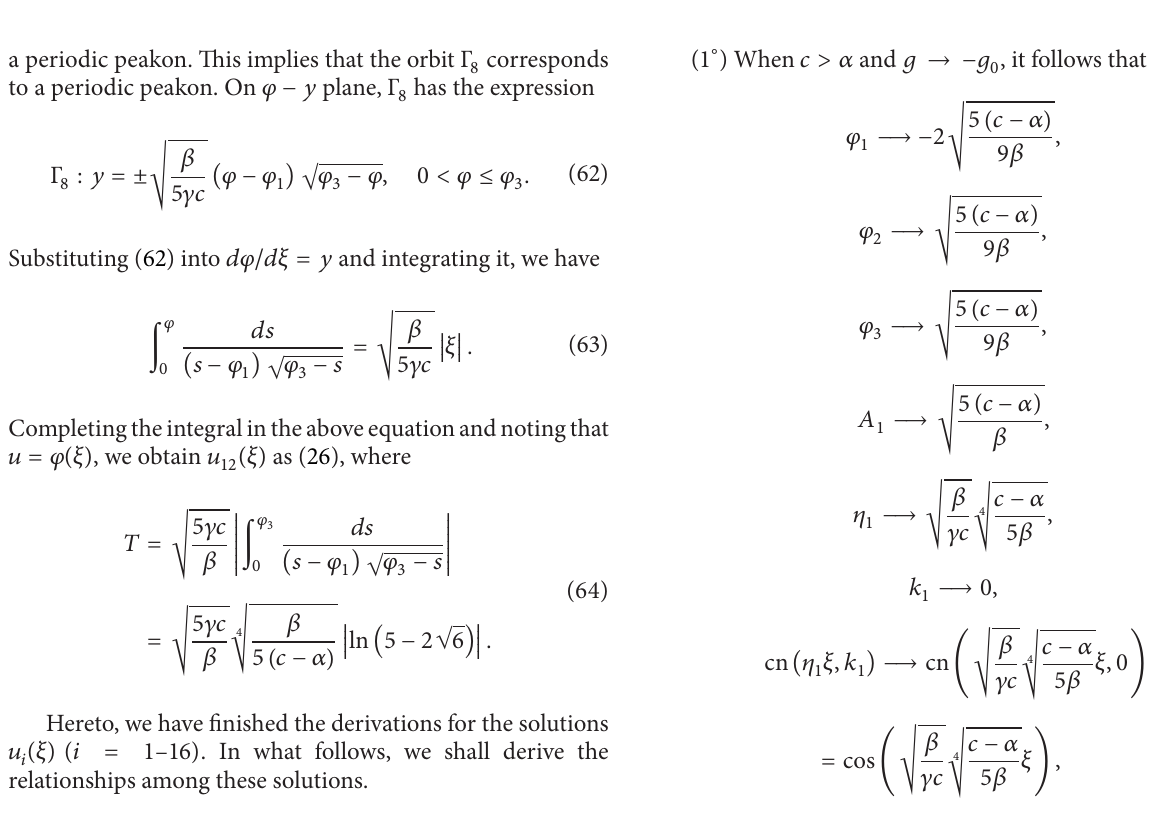
Figure 12: The simulation of integral curves of (40) when 𝛼 = 𝛽 = 𝛾 = 1 , 𝑐 = 2 , 𝑔 = 4√5/27 , (b) initial value 𝜑(0) = 0.5 , (c) initial value 𝜑(0) = 0.1 , and (d) initial value 𝜑(0) = 0.0001